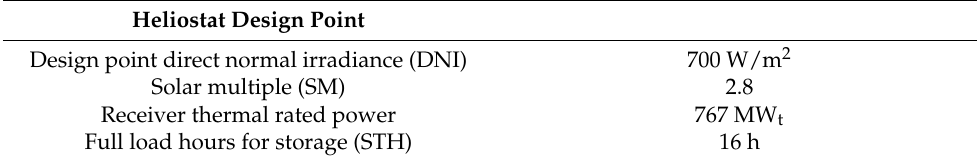
Table 3. Heliostat field design point parameters for the CSP.